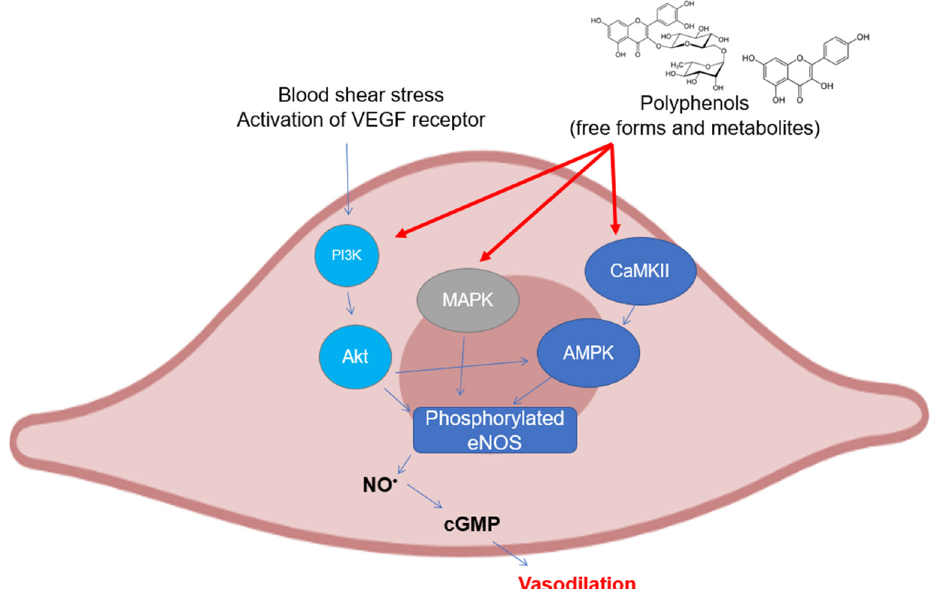
Figure 3. Polyphenols elicit eNOS phosphorylation in endothelial cells through the activation of different upstream kinases. Abbreviations : AMPK—5’ AMP-activated protein kinase; CaMKII— Ca2+/calmodulin dependent kinase II; cGMP—guanosine 3’,5’-cyclic monophosphate; eNOS—en- dothelial nitric oxide synthase; MAPK—mitogen activated protein kinase; NO—nitric oxide;